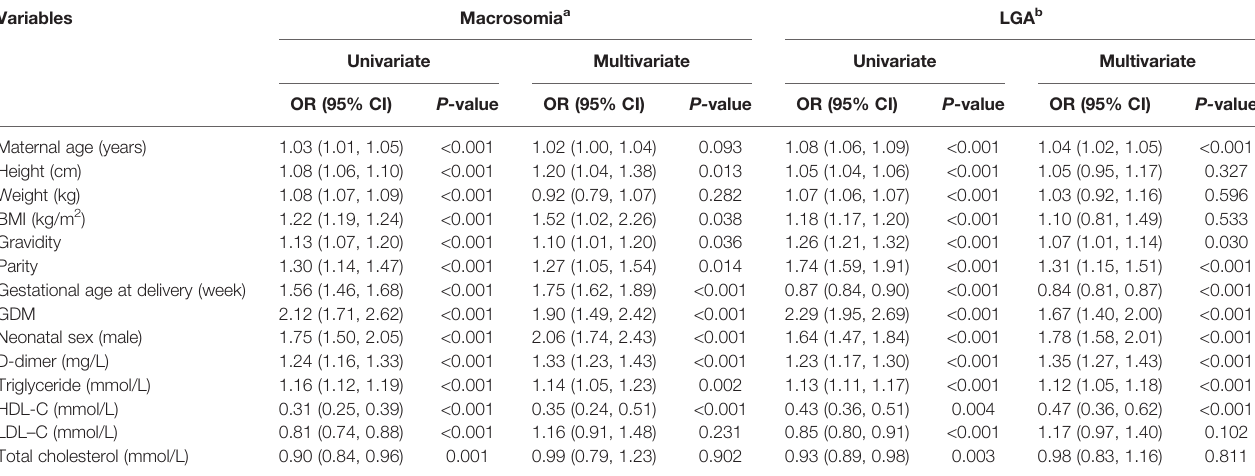
TABLE 4 | The risk factors associated with the incident macrosomia and LGA neonates in late